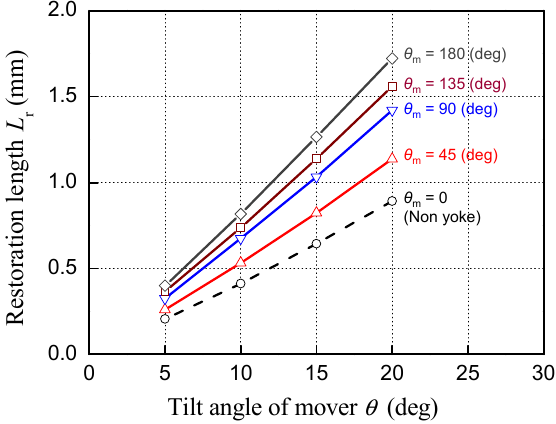
Figure 8. Relationship between the tilt angle and restoration length.